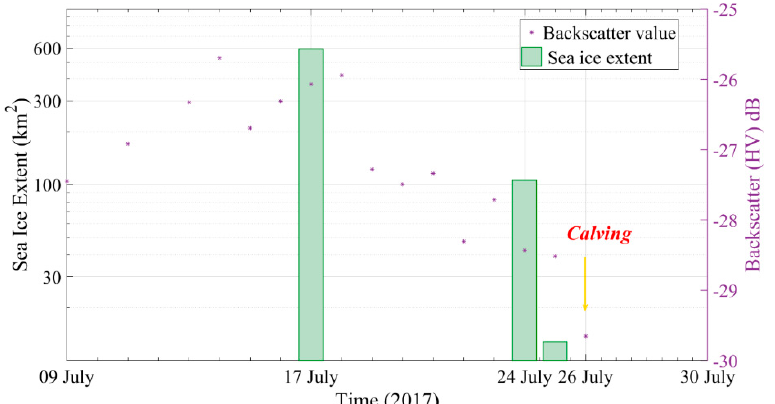
Figure 9. The evolution of sea-ice extent and backscatter of the surrounding sea ice of the ice front during July 2017 prior to calving events (26 July 2017).